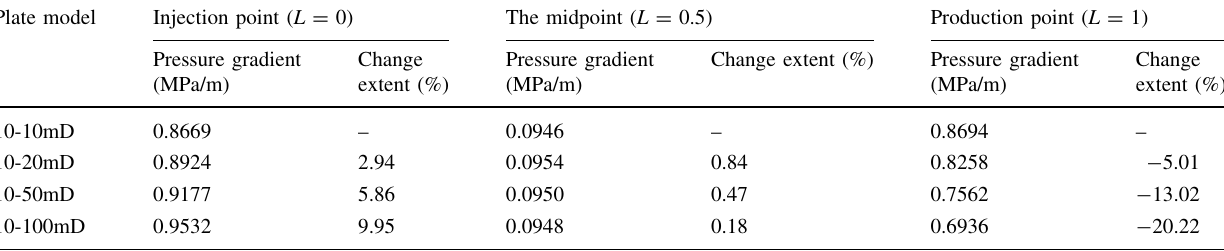
Table 1 Pressure gradient of connection line of injection and production points Plate model